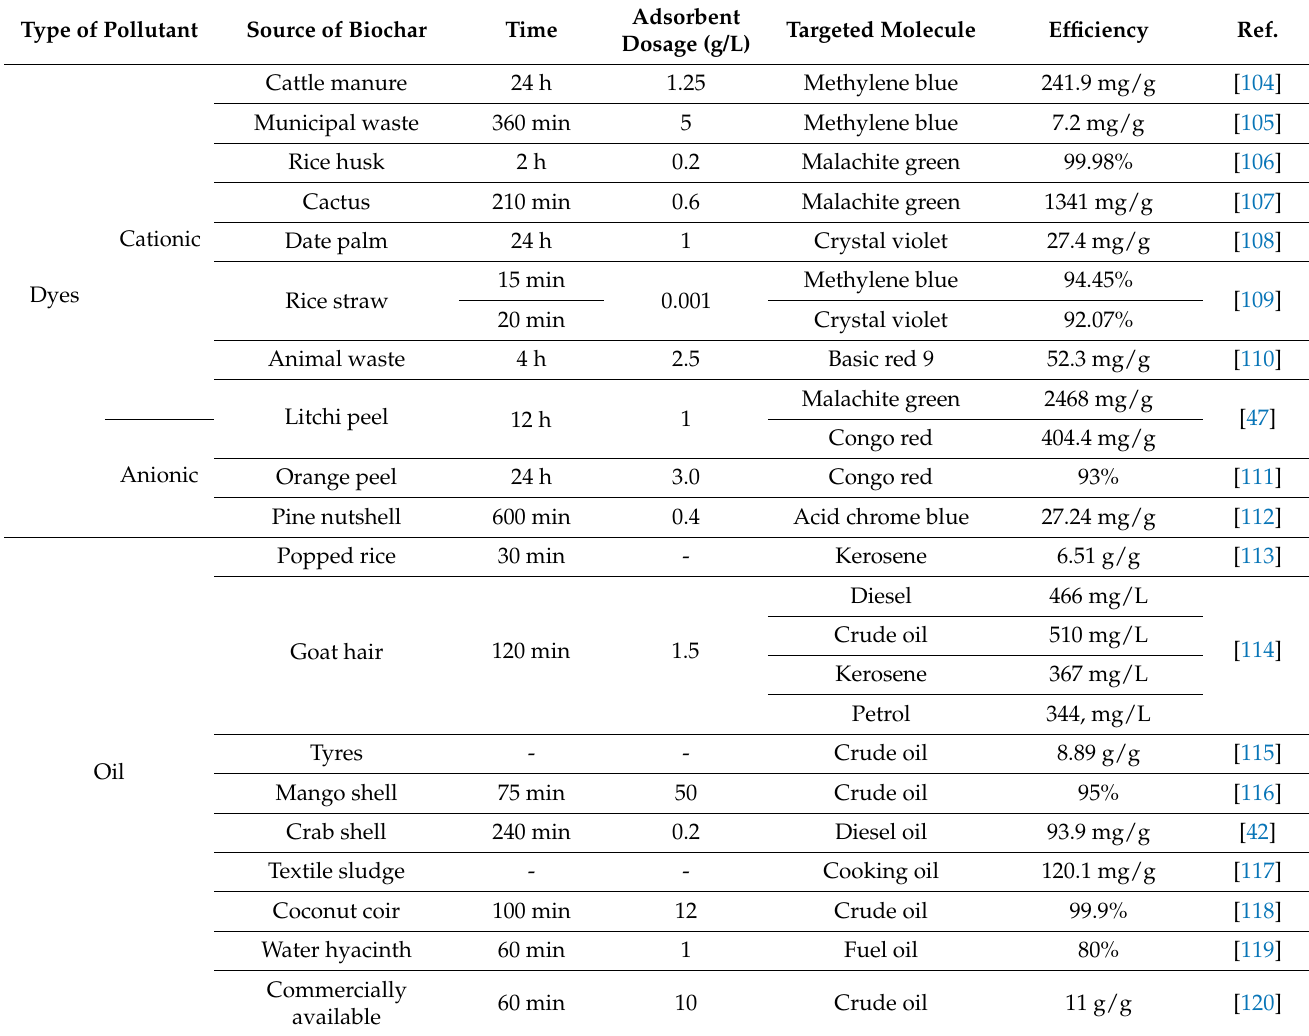
Table 2. Sources, time, adsorbent dosage, targeted pollutant molecules, and adsorption efficiency of